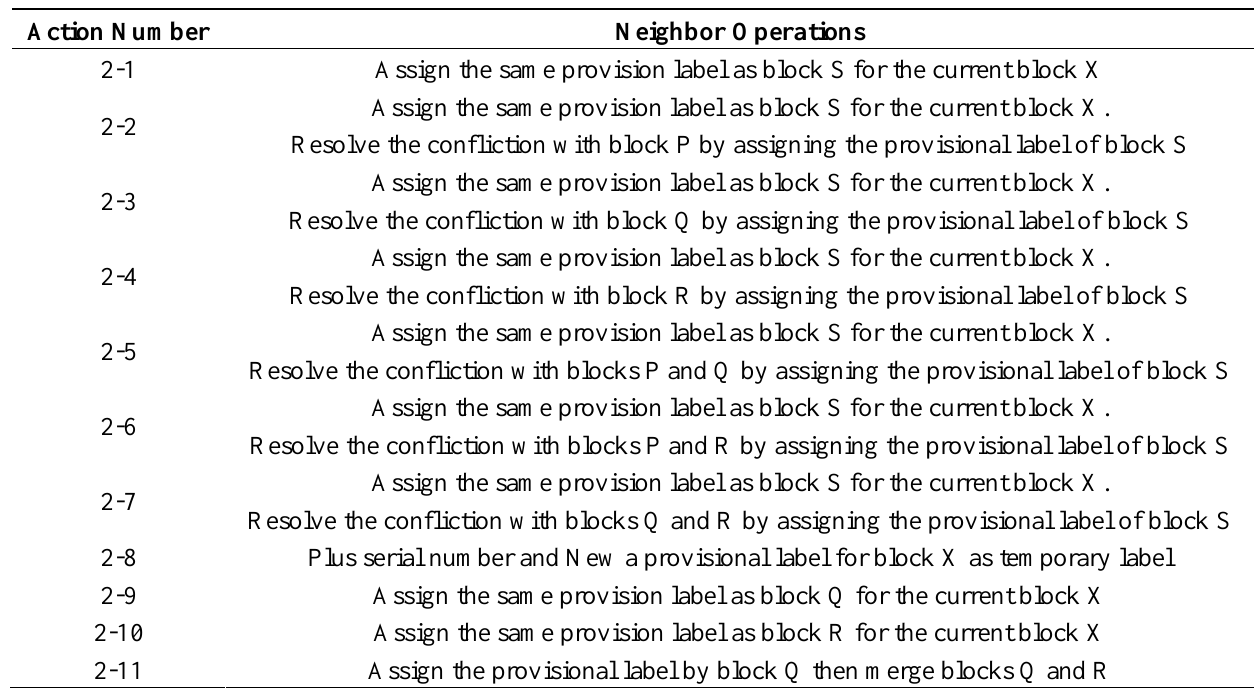
Table 2. Actions of procedure